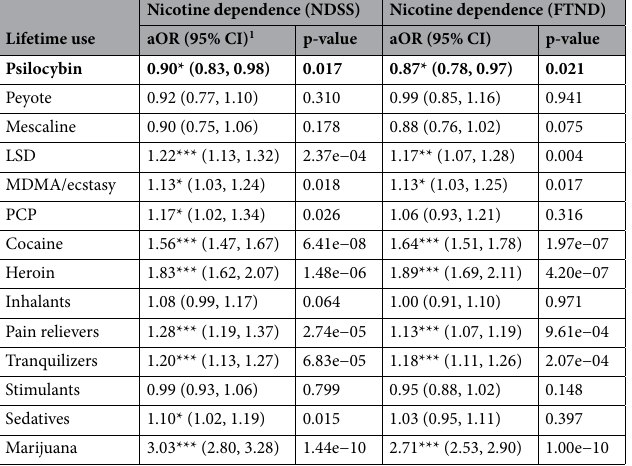
Table 2. Associations between lifetime substance use and two measures of nicotine dependence. Significant values conferring lowered odds of nicotine dependence are in bold. 1 *p < 0.05; **p < 0.01; ***p < 0.001; aOR adjusted odds ratio, CI confidence interval.